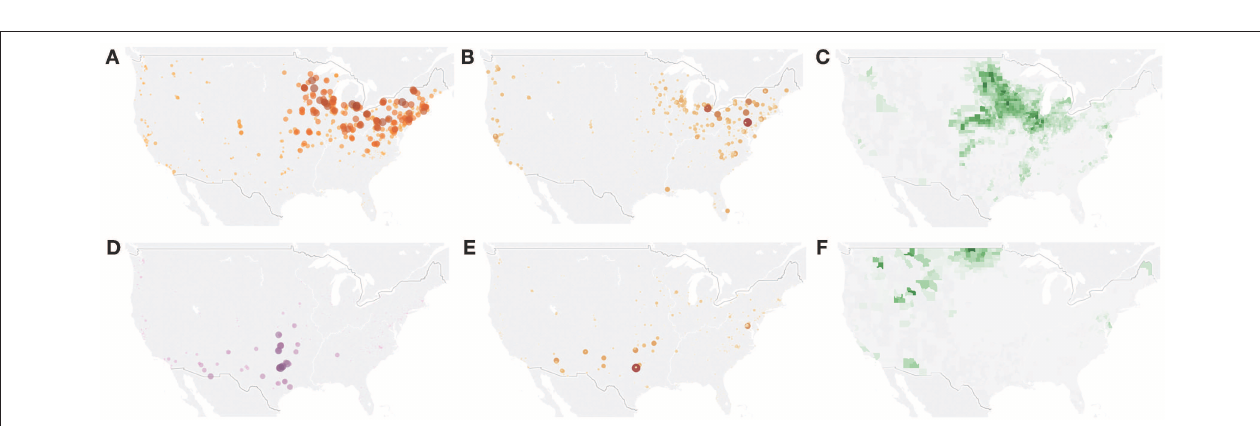
FIGURE 4 | Map of the probability to be associated with the Northern partition (A) . Relative abundance of Epicoccum nigrum in dust samples (B) . County-level corn production data from the United States Department of Agriculture (USDA) (C) . Map of the probability to be associated with the Southern partition (D) . Relative abundance of Ascochyta hordei in dust samples (E) . County-level barley production data from the United States Department of Agriculture (USDA) (F) .